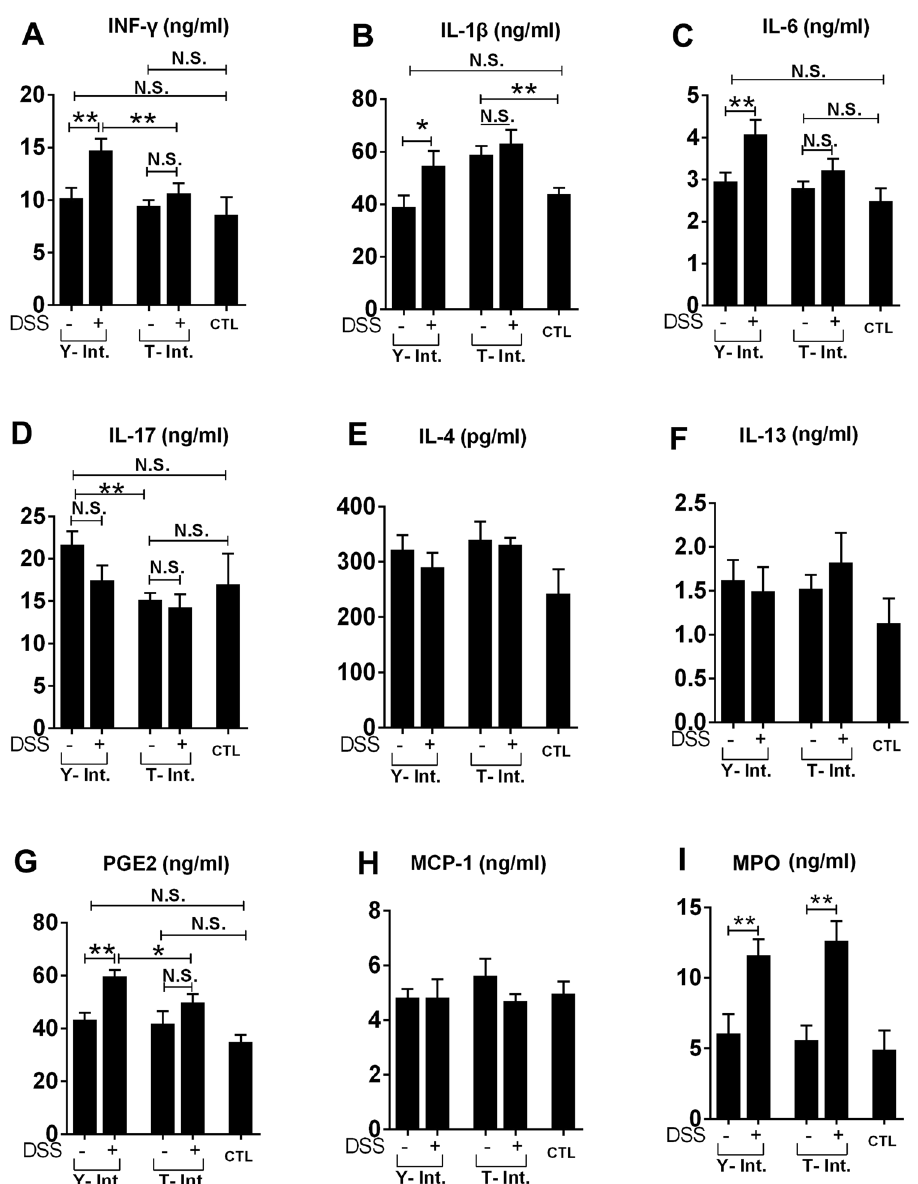
Figure 6. Quantitation of cytokines in colonic tissues from the piglets by ELISA. The faecal microbiota of the Yorkshire and Tibetan pigs was transplanted in healthy commercial hybrid newborn piglets to establish the “Yorkshire-intervened” (Y-int.) and “Tibetan-intervened” (T-int.) porcine models. CTL, control group (without DSS and FMT). The results are presented as the mean ± the SEM. Statistical significance was estimated using two-way ANOVA with DSS treatment and faecal microbiota transplantation as the independent variables. * P < 0.05; ** P < 0.01. N.S., no significant difference. Each n =